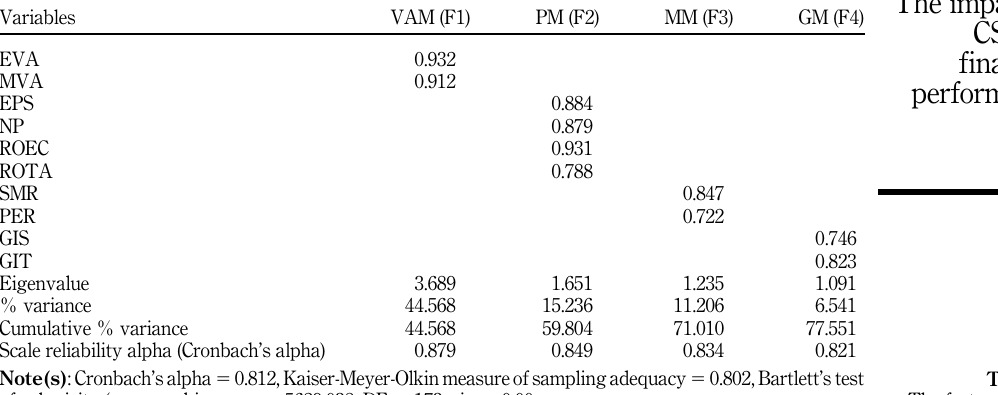
Table 6. The factor analysis